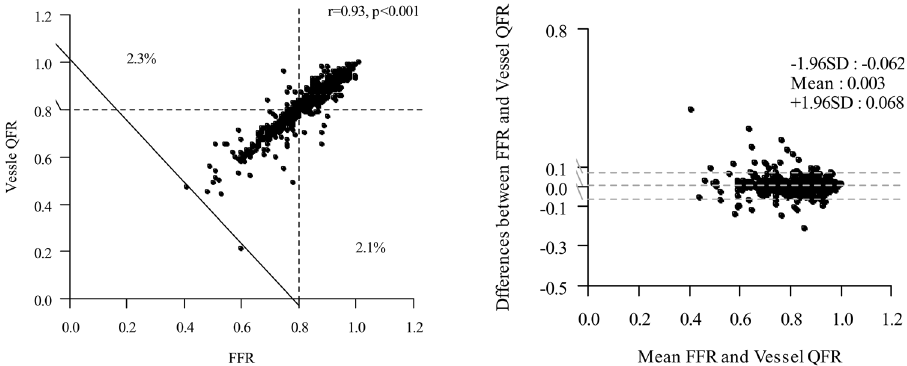
Figure 2. Correlation and agreement between QFR and FFR. Scatter plot shows the correlations between the FFR and QFR in all patients (r = 0.93, Pearson’s rank correlation coefficient). Differences between the FFR and QFR versus the means of the two measurements shown in a Bland–Altman